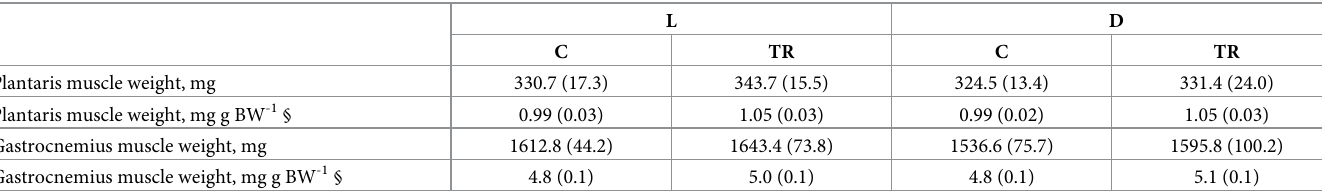
Table 1. Effect of eccentric exercise on plantaris and gastrocnemius muscle weight at different times of the day for 8 weeks. L